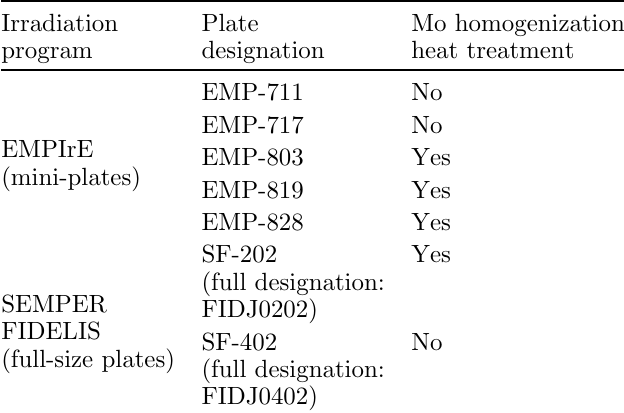
Table 1. Main characteristics of EMPIrE and SEMPER FIDELIS plates.